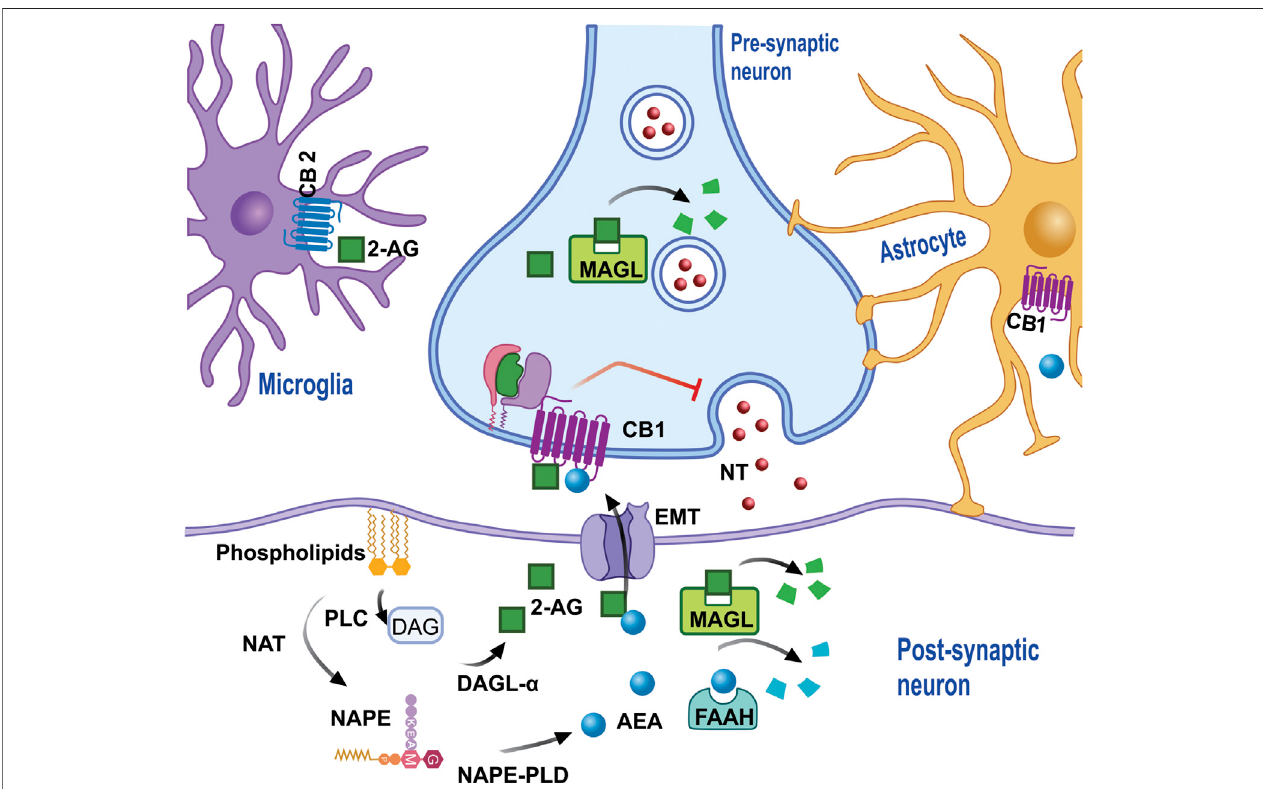
FIGURE 2 | eCB is synthesized from membrane phospholipids. NAT synthesizes the precursor NAPE, which subsequently, through the action of PLD, produces AEA in the cytoplasm of the post-synaptic neuron (or neuron spine). AEA leaves the cytoplasm and enters the synaptic space via diffusion and/or the action of EMT in order that, once it has onside, AEA activates the cannabinoid receptors which inhibit the release of NT. The degradation of AEA in EMT is regulated by FAAH, which producesmetabolitessuchasAAandETA.2-AGrequirestheformationoftheDAGprecursorbyPLC,whichthenthroughtheactionofdiacylglycerollipase α ,and together with arachidonic acid generates 2-AG, which then leaves the synaptic space to activate cannabinoid receptors, which are also present in the microglia and/or astrocytes, and can be degraded by MAGL both in the pre and post-synapse, generating AA and Gro as metabolites. Abbreviations: eCB, endocannabinoids; NAT, N-acyl transferase; NAPE, N-acyl-phosphatidylethanolamine; PLD, phospholipase D; AEA, anandamide; NT, neurotransmitters; EMT, endocannabinoid membrane transporter; FAAH, fatty acid amide hydrolase; AA, arachidonic acid; ETA, ethanolamine; 2-AG, 2- Arachidonoylglycerol; DAG, diacylglycerol; PLC, phospholipase C; MAGL, monoacylglycerol